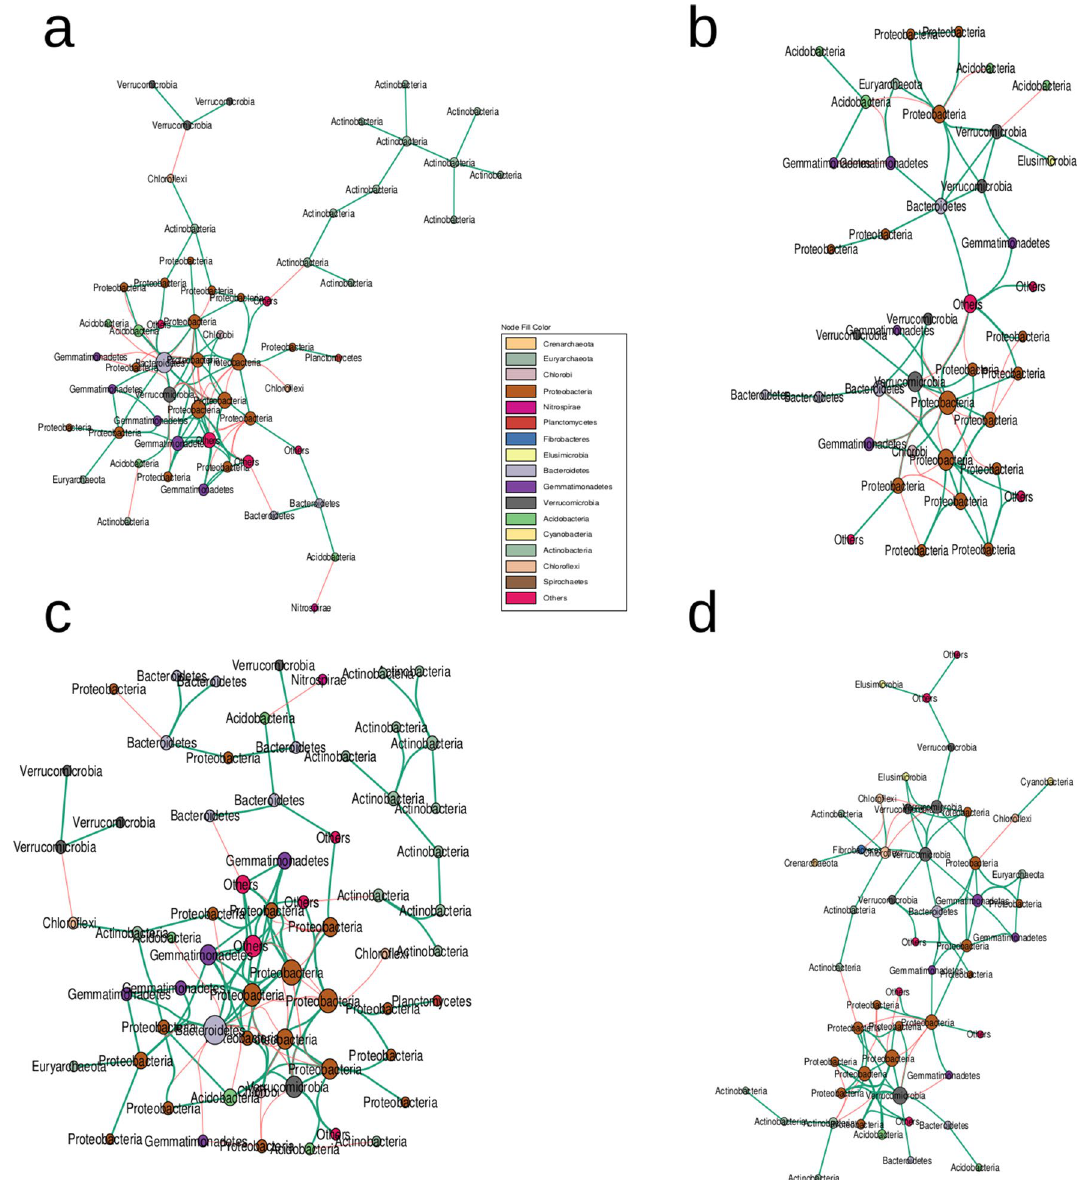
durum elite cultivars rhizosphere bacterial cooccurence networks, respectively. Edges indicate positive (green) or negative correlations (red) as defined by Spearmann’s correlation coefficients ρ > 0.6 or ρ < − 0.6, respectively. Node colors differ according to OTUs phylum